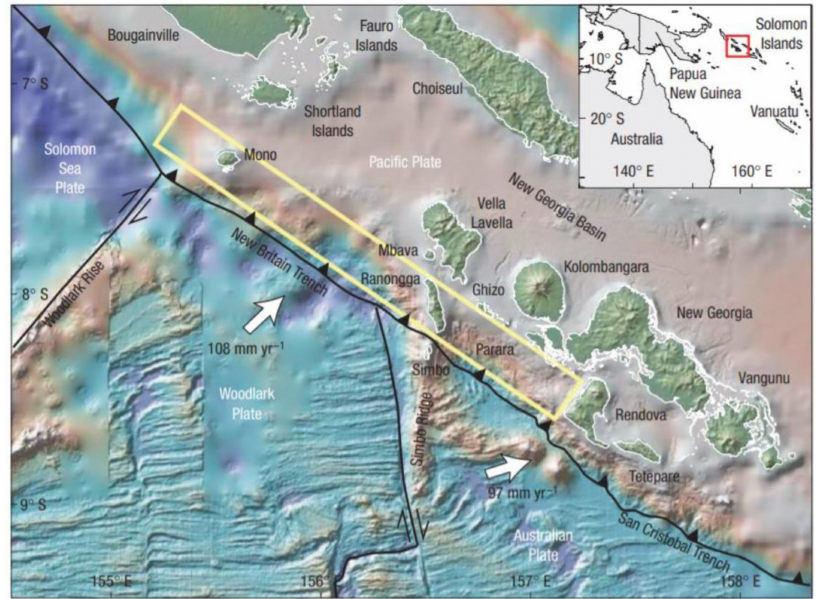
Figure 1. Geotectonic location of the 2007 Western Solomons Earthquake (Taylor, 2008 acknowledge- ment Nature Publications). The inset shows the location of the western Solomon Islands. The yellow rectangle indicates the main zone of tectonic thrusting linked to the earthquake. The black lines indicate plate boundaries. White arrows indicate velocity of plate motions. The main islands of the western Solomons are named. Colour tones refer to relative depths beneath sea level, with deeper and darker tones indicating deeper ocean. Readers are also referred to https://www.usgs.gov/centers/ pcmsc/science/preliminary-analysis-april-2007-solomon-islands-tsunami-southwest-pacific (ac- cessed on: 15 August 2021) and https://agupubs.onlinelibrary.wiley.com/doi/pdf/10.1029/2008 EO180001 for further details (accessed on: 15 August